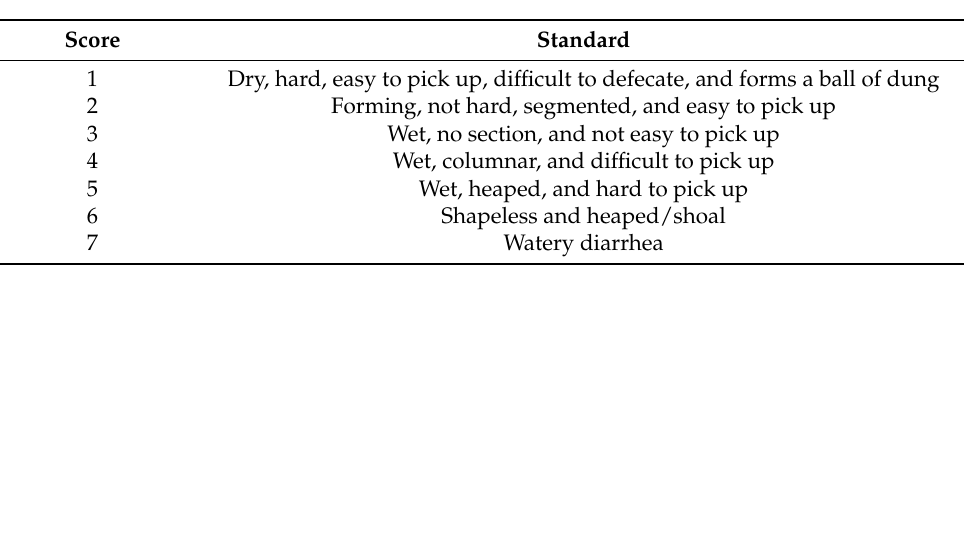
Table A1. Fecal condition